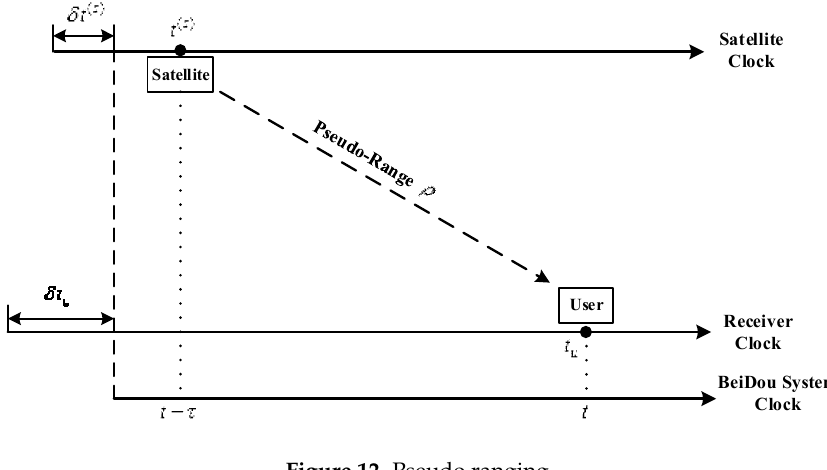
Figure 12. Pseudo ranging.